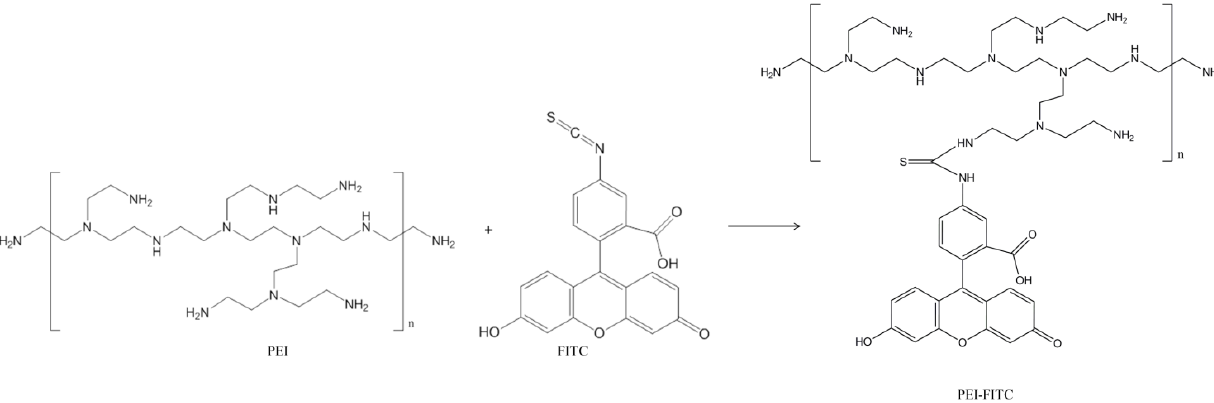
Figure 6. Scheme of a possible chemical path for the functionalization of polyethyleneimine (PEI) with the fluorophore